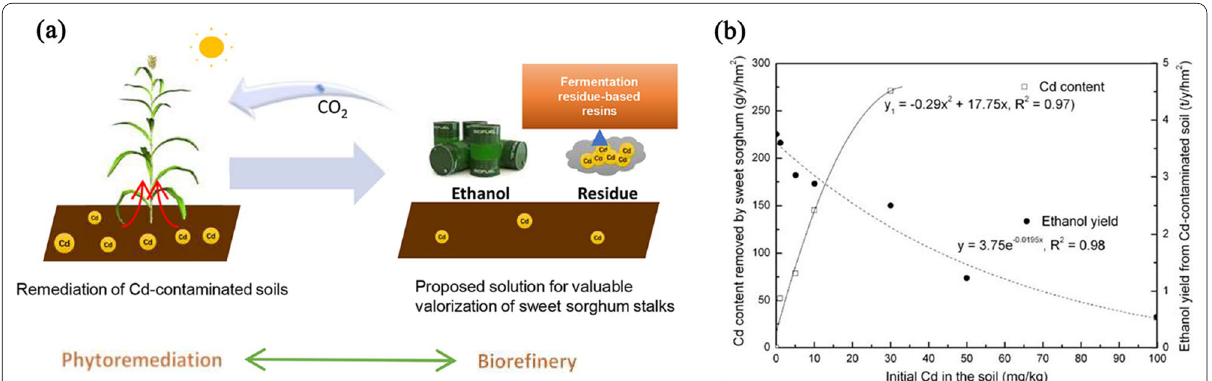
Fig. 5 Bioenergy potential of sweet sorghum for Cd‑polluted soil phytoremediation. a Proposed strategy of using sweet sorghum integrated with phytoremediation and biorefinery. Reprinted from [22], Elsevier B. V., Copyright (2021). b Predicted removable Cd content and ethanol yield of sweet sorghum at different Cd concentration levels. Reprinted from [65], Taylor & Francis Ltd (http:// www. tandf online. com), Copyright